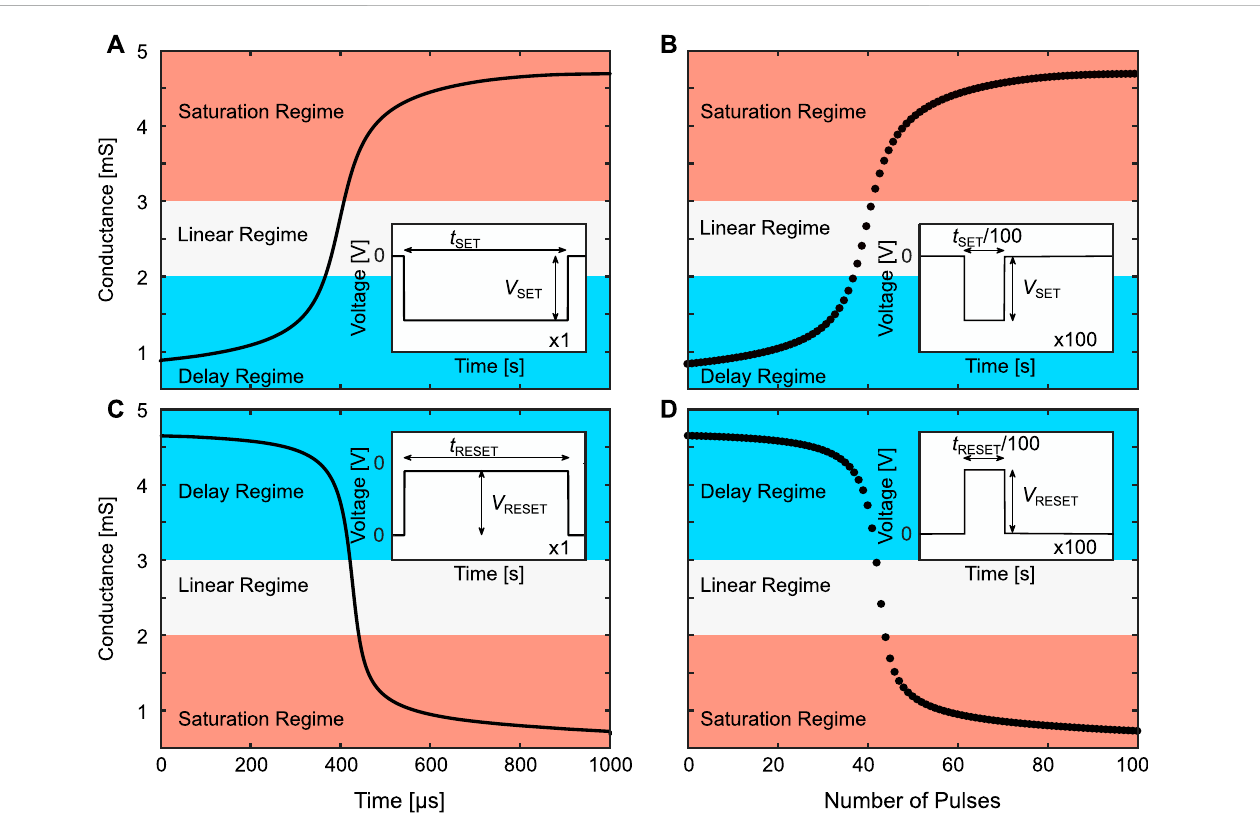
FIGURE 3 Simulated strong and weak programming of the VCM device. The transient obtained for one single pulse can be can be divided into a corresponding pulsed conductance evolution by utilizing weak programming. (A) Strong programming transient of a SET obtained for one pulse at − 600 mV for t SET = 1 ms. (B) Weak programming pulse equivalent of the SET transient by utilizing a pulse train with 1 of the single pulse width and the same amplitude. (C) Strong 100 programming transient of the RESET depicted for one pulse at 800 mV for t RESET = 1 ms. (D) Corresponding weak programming pulse equivalent of the RESET transient utilizing apulsetrain with 1 ofthesingle pulse widthand thesameamplitude. The pulserise andfall timeswerechosenas t rise,fall =10 – 11 sto 100 be signi fi cantly shorter than the pulses